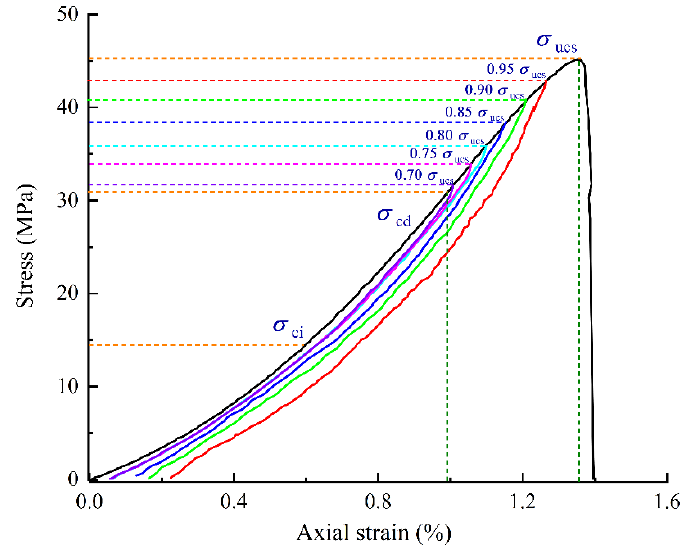
Figure 6. Complete uniaxial loading and unloading compression curves of sandstone (black line: the complete stress-strain curve; the unloading stress-strain curve when unloading stress is (1) 0.95 UCS in red line; (2) 0.90 UCS in green line; (3) 0.85 UCS in blue line; (4) 0.80 UCS in cyan line; (5) 0.75 UCS in peach line; (6) 0.70 UCS in purple line).